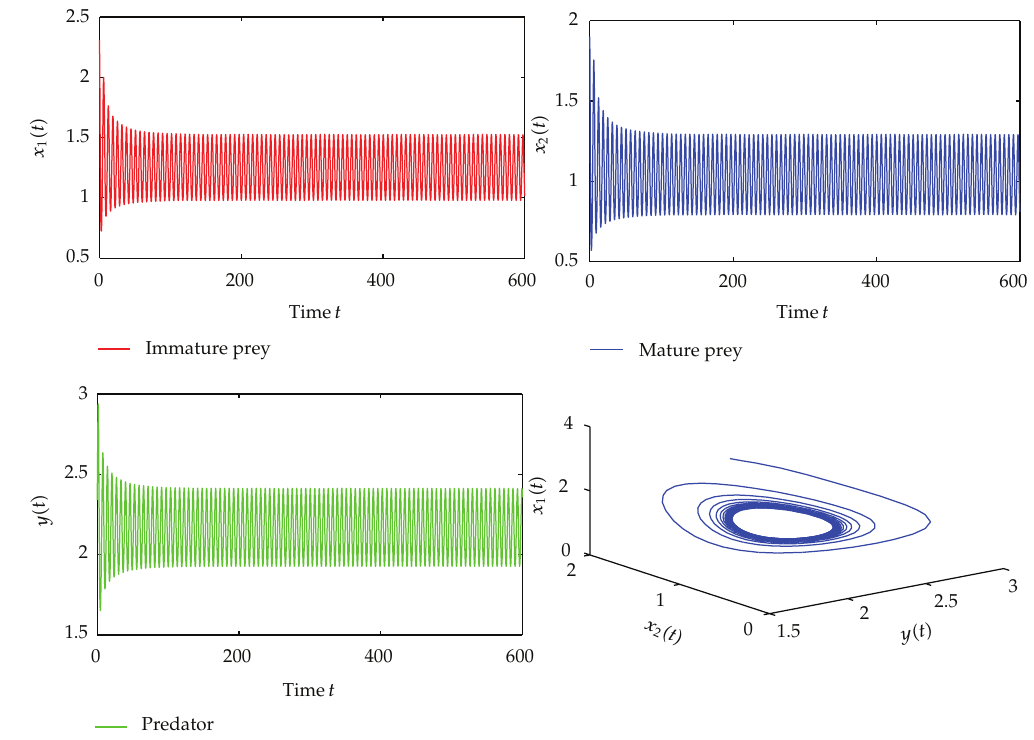
Figure 6: E 0 is unstable for τ (cid:6) 0 . 4600 > τ 0 (cid:6) 0 . 4178 with initial value “2.31; 1.9;